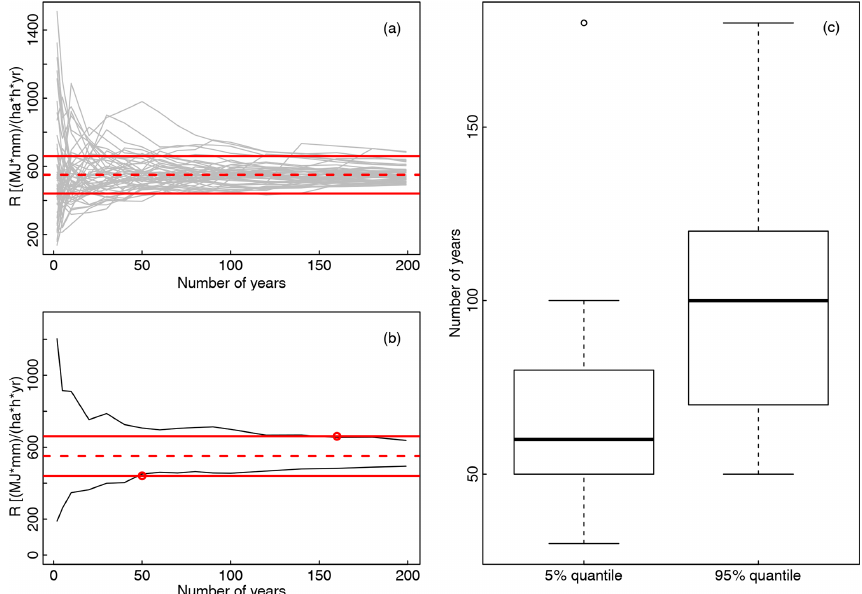
Figure 10. Relationship between mean annual rainfall erosivity and number of years used in the rainfall erosivity calculation. Panel (a) shows 50 different realisations (grey lines) together with the mean annual value calculated using all 50 realisations with 200 years of data (dotted red line) and ± 20% of this mean value (solid red line). Panel (b) shows 5% and 95% quantile values (black line) calculated based on 50 realisations shown in (a) and intersections between these quantile values and the ± 20% interval. Panel (c) shows boxplots of intersection points for 17 stations for the 5% and 95% quantiles. Panels (a) and (b) are shown for station ID = 10113